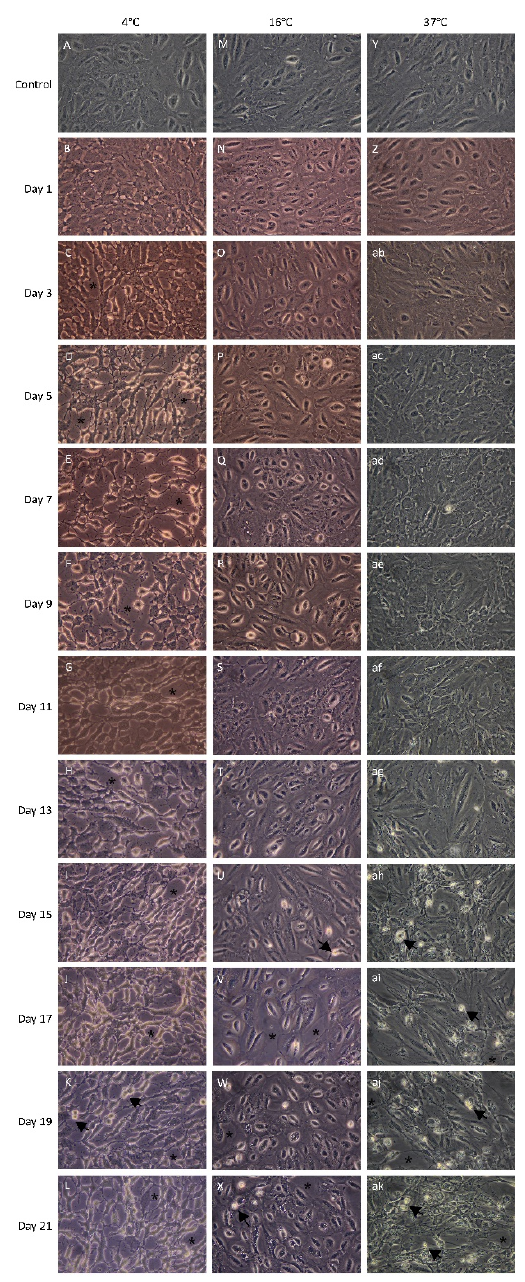
Figure 2. Effect of storage temperature on the morphology of adult retinal pigment epithelial (ARPE-19) cells. Phase-contrast photomicrographs were captured every alternate day during the storage period. Photomicrographs A, M and Y show ARPE-19 cell cultures before storage at three different temperatures. Photomicrograph B–L, N–X, and Z–ak demonstrate the morphology of the ARPE-19 cell cultures following 1 to 21 days of storage at 4 °C, 16 °C and 37 °C, respectively. Black arrows indicate apoptotic cells. Asterisks indicate intercellular spacing (magnification: 400×; n = 4).